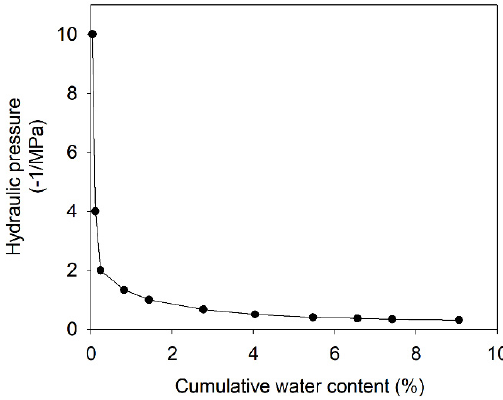
Figure 1. An example pressure–volume (P–V) curve of shoots in lacebark pine seedlings. Depending on the applied pressure, each PV–curve had two distinct ranges: a nonlinear and a linear range [39]. The osmotic potential at the turgor-loss point ( ψ tlp , MPa) for initial plasmolysis was the turning point where the curve changed to a straight line. The corresponding accumulated expressed sap at the turning point was V tlp . The relative water content of the initial plasmolysis was (RWC tlp ,%) = 1 − V tlp .The intersection point of the extension line of the PV curve straight line and the Y–axis was the saturation water osmotic potential ( ψ sat , MPa). The symplastic water content at full turgor (V s ,%) was obtained from the intersection of the extrapolated line of the PV curve straight line and the x -axis. The apoplastic water content was (V a ,%) = 1 − V s. The free water was (V p, %) = V s − V tlp [9,40]—the ratio of V a and V p was calculated accordingly. The cell elastic modulus was ( ε , unit MPa) = Δψ P / Δ RWC. When the water was extruded from plant tissue, ε changed continuously. Therefore,